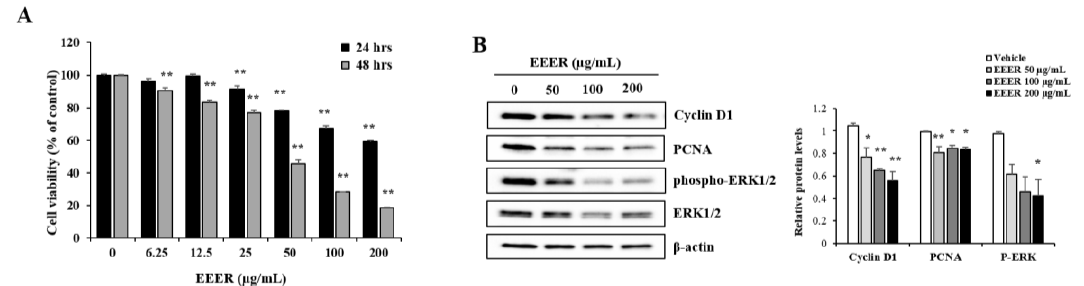
Figure 3. Effect of EEER on the growth of BPH-1 cells. ( A ) Cells were treated with vehicle or EEER for 24 and 48 h at the indicated concentration and the relative cell viability was assessed using the CCK-8 assay. DMSO was used as the vehicle. ( B ) The assessment of protein expression levels was performed via western blot analysis ( left ) . The relative cyclin D1 and PCNA levels and phospho-ERK1/2 levels were normalized to that of β-actin and ERK1/2 levels, respectively. The densitometric analysis was performed using the Image Lab software ( right ). The data are the mean ± SEM of three independent experiments. * p < 0.05 and ** p < 0.01 compared with the vehicle control.